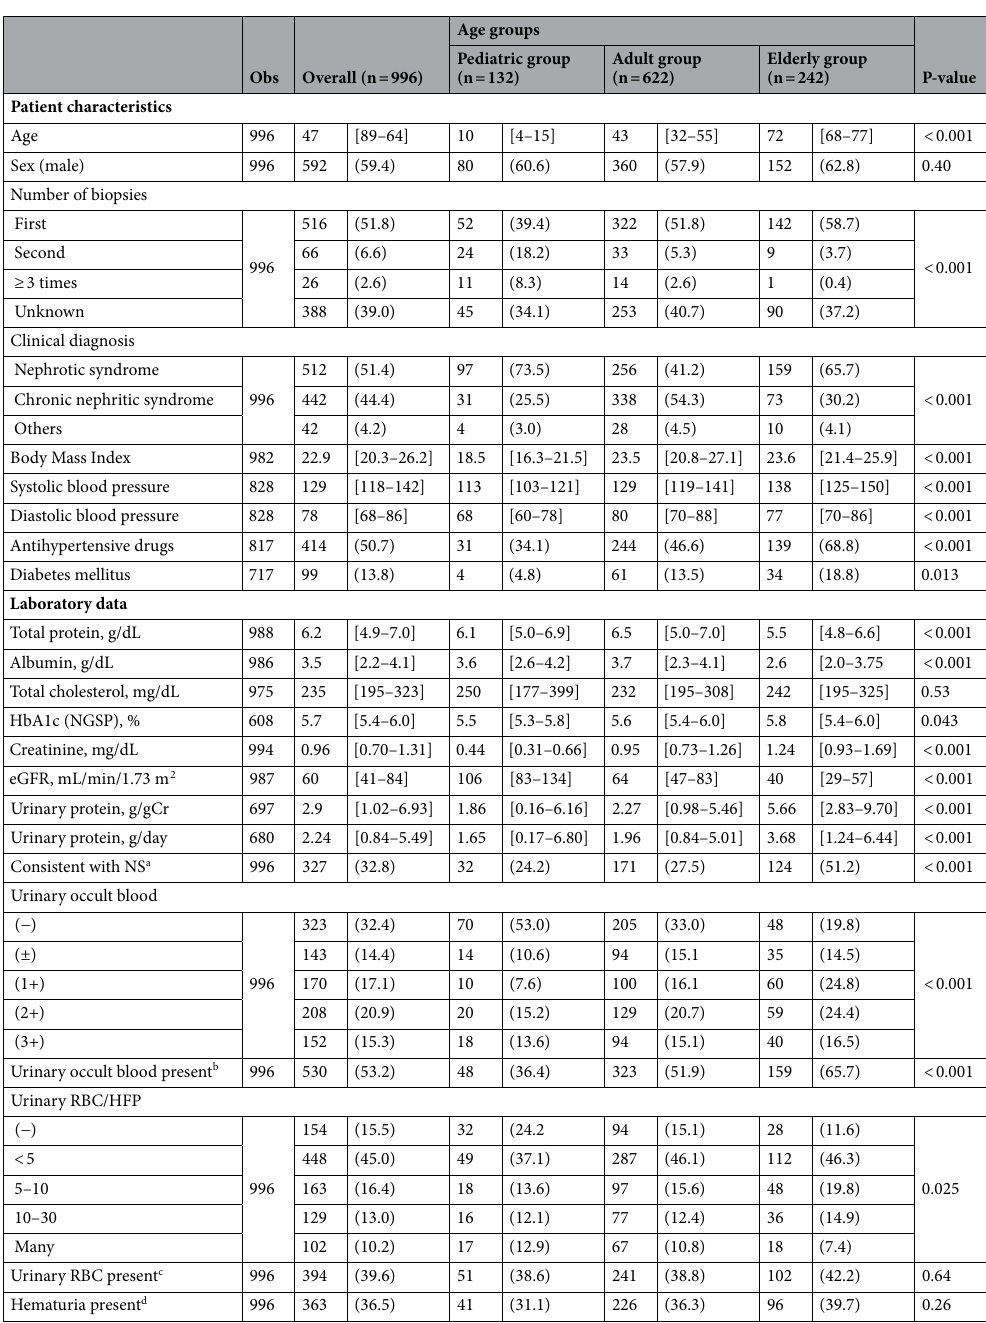
Table 1. Clinical features of primary FSGS in the Japan Renal Biopsy Registry. Data are presented as median [interquartile range] for continuous variables and count (percentage) for categorical variables. obs number